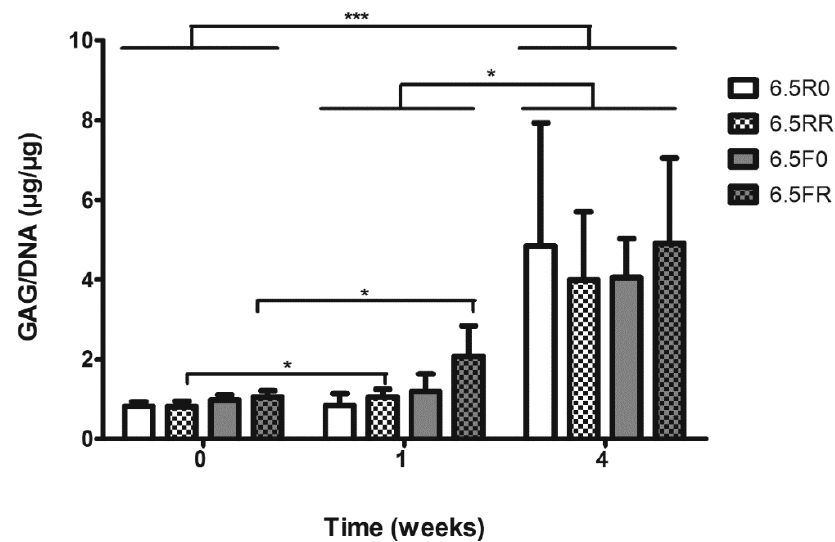
Figure 8. GAG/DNA content of ATDC5 cells encapsulated inside 6.5 ( w / v ) PEG hydrogels varying in the cross-linker type (F or R) and RGD content (0 or 150 µ M), and cultured over time in 4C chondrogenic medium. 6.5R0 = R cross-linker + 0 µ M RGD; 6.5RR = R cross-linker + 150 µ M RGD; 6.5F0 = F cross-linker + 0 µ M RGD; 6.5FR = F cross-linker + 150 µ M RGD. Results depicted as mean ± SD (Two-way ANOVA n = 3; * p < 0.05; *** p < 0.001).